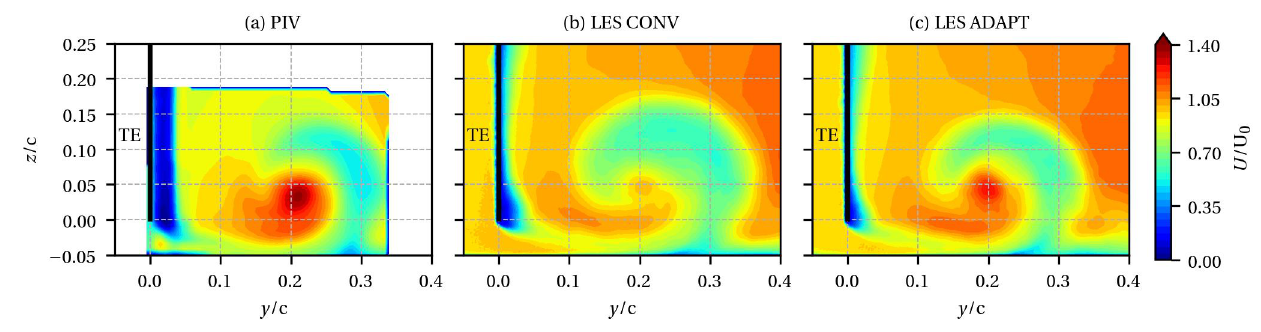
Figure 11. Longitudinal velocity component U of the tip leakage vortex at the airfoil trailing edge ( x /c = 0.01). To deepen the analysis, 1D velocity profiles are plotted at z /c = 0.05 in Figure 12. Using the mesh adaptation, the predicted velocity profile is clearly improved. Indeed, whereas the deficit of velocity caused by the airfoil wake is retrieved by both LES around y /c = 0 with the correct amplitude, some discrepancies are observed in the tip leakage vortex zone, which extends from y /c = 0.17 to 0.35. Indeed, the LES with mesh adaptation in green is able to recover the amplitude of the maximum U at y /c = 0.2. Mesh adaptation allows to recover the complex structure of the tip leakage vortex and especially the acceleration of the longitudinal velocity